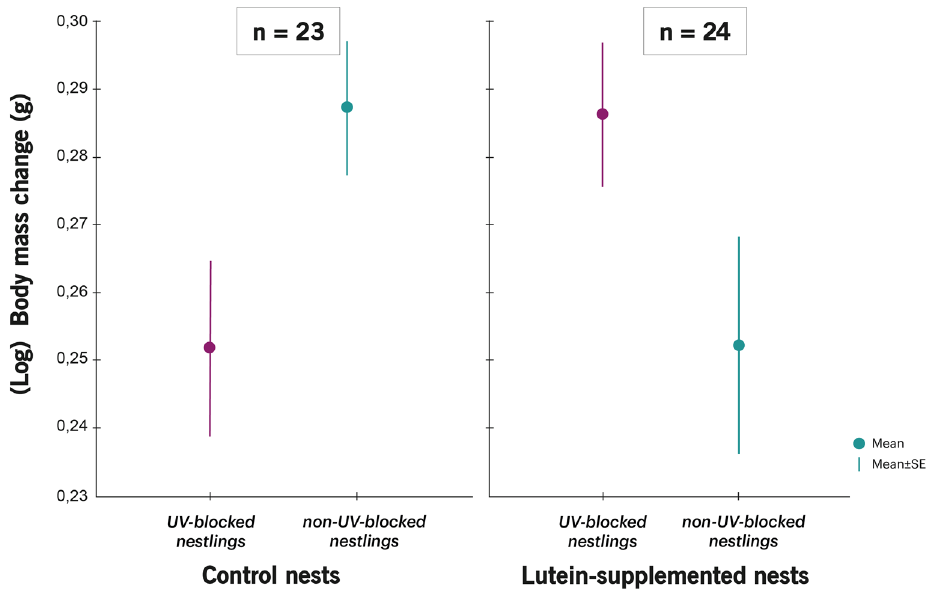
Figure 3. Nestling (log 10 ) body mass change (mean ± SE) according to nestling UV manipulation and female supplementation treatment. Values are (mean ± SE) residuals from a model plus the average difference in (log 10 ) body mass change that includes all variables except the interaction between both treatments. Sample sizes for control females and lutein-supplemented females are shown. See in Supplementary material the figure for body mass change (not log